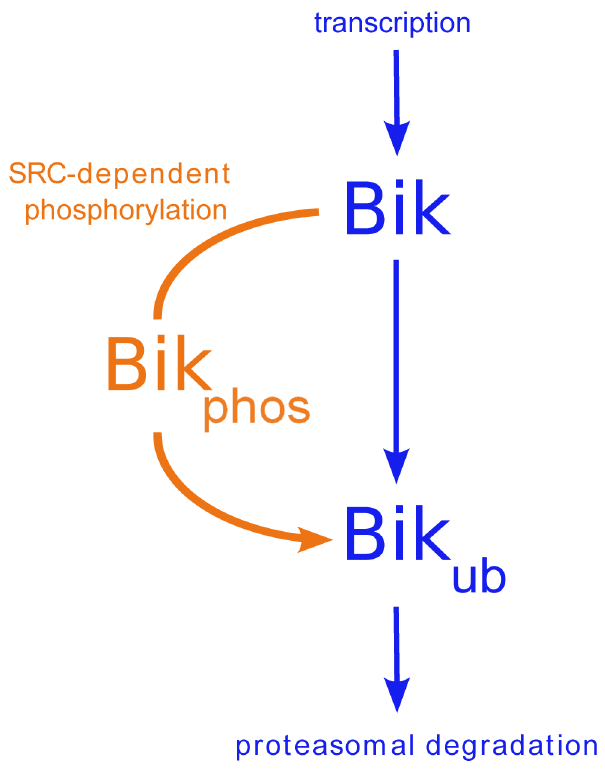
Figure 1. Bik kinetics in non-apoptotic conditions. Bik proteins are polyubiquitylated ( Bik ub ) prior to their proteasomal degradation. This ubiquitylation occurs spontaneously in parental NIH-3T3 cells and is enhanced in Src-transformed cells through Src-dependent activation of Erk1/2 kinases which accelerate Bik phosphorylation ( Bik phos ), thus favoring its ubiquitylation.